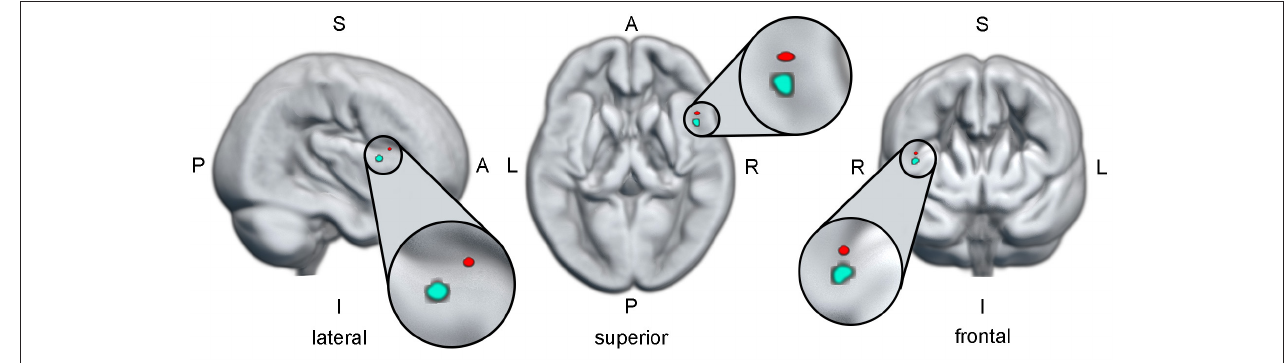
FIGURE 5 | The red dot indicates the region in the right inferior frontal gyrus, where a higher activation during alcohol-related inhibition is predictive for higher craving. The cyan dot indicates the region in the right inferior frontal gyrus, where a higher activation during alcohol-specific inhibition is predictive for a better drinking outcome. The anatomical brain render used for this illustration is based on the mean normalized gray matter image of all participants included in this study. All three views were cut from the surface to the localization of the cyan ROI. Since the red ROI is on the same pane as the cyan ROI only in the lateral view, the red ROI should be viewed as “hovering in the air” in the superior and frontal views. A, anterior; I, inferior; L, left; P, posterior; R, right; ROI, region of interest; S,